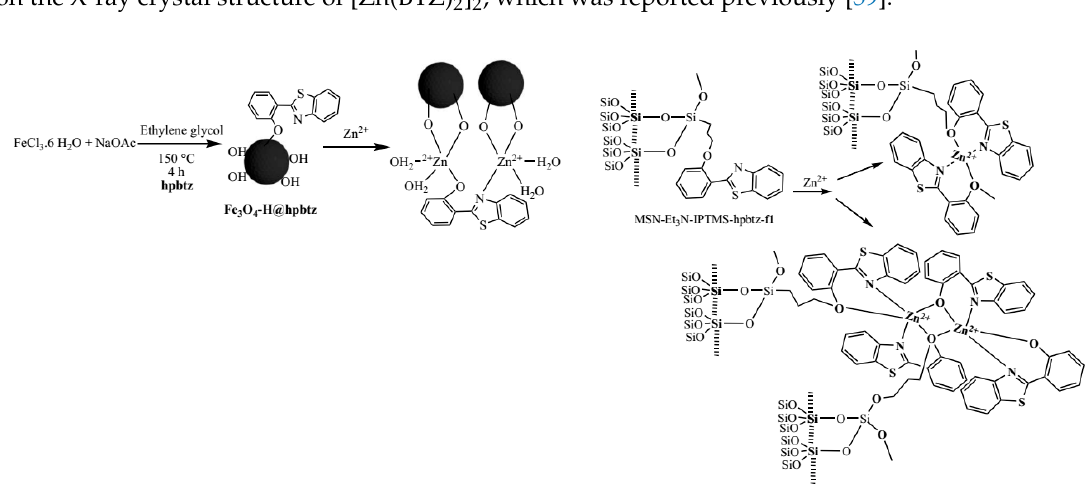
Figure 15. Variation of the fluorescence intensity of MSN-Et 3 N-IPTMS-hpbtz- f1 (2 mg mL − 1 ), with Zn 2+ (15.4 equivalent, 350 µL) and various metal ions (two times more in equivalent) at 460 nm ( λ ex = 305 nm) in